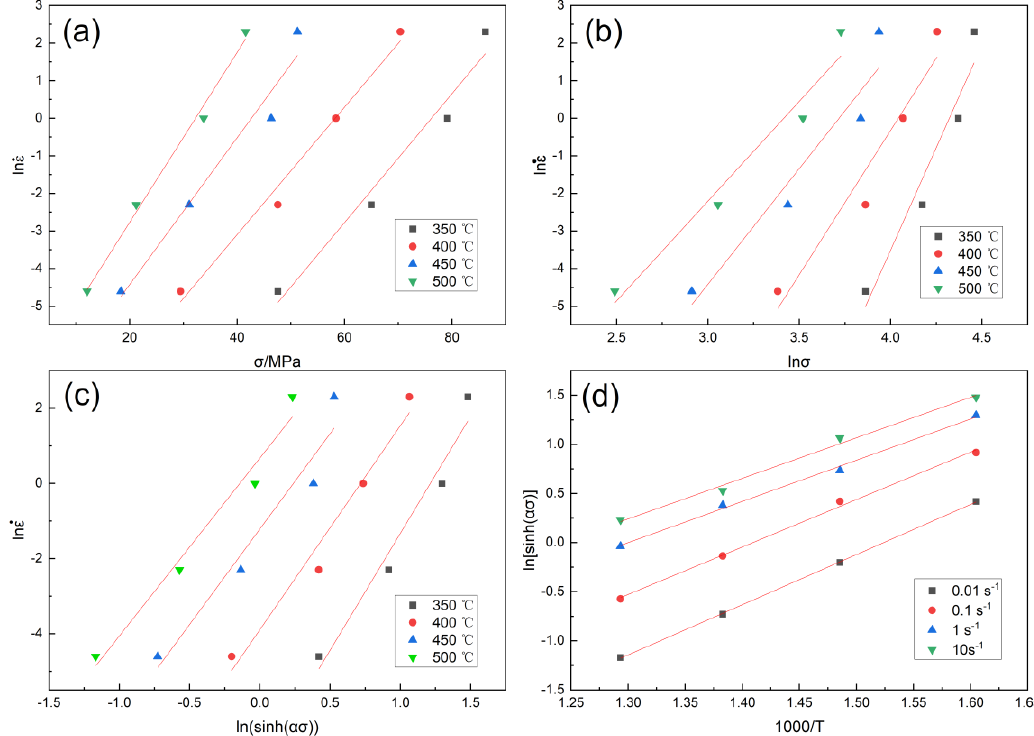
. . . ε − σ ; ( b ) ln ε − ln σ ; ( c ) ln ε − ln[sin h( ασ )];